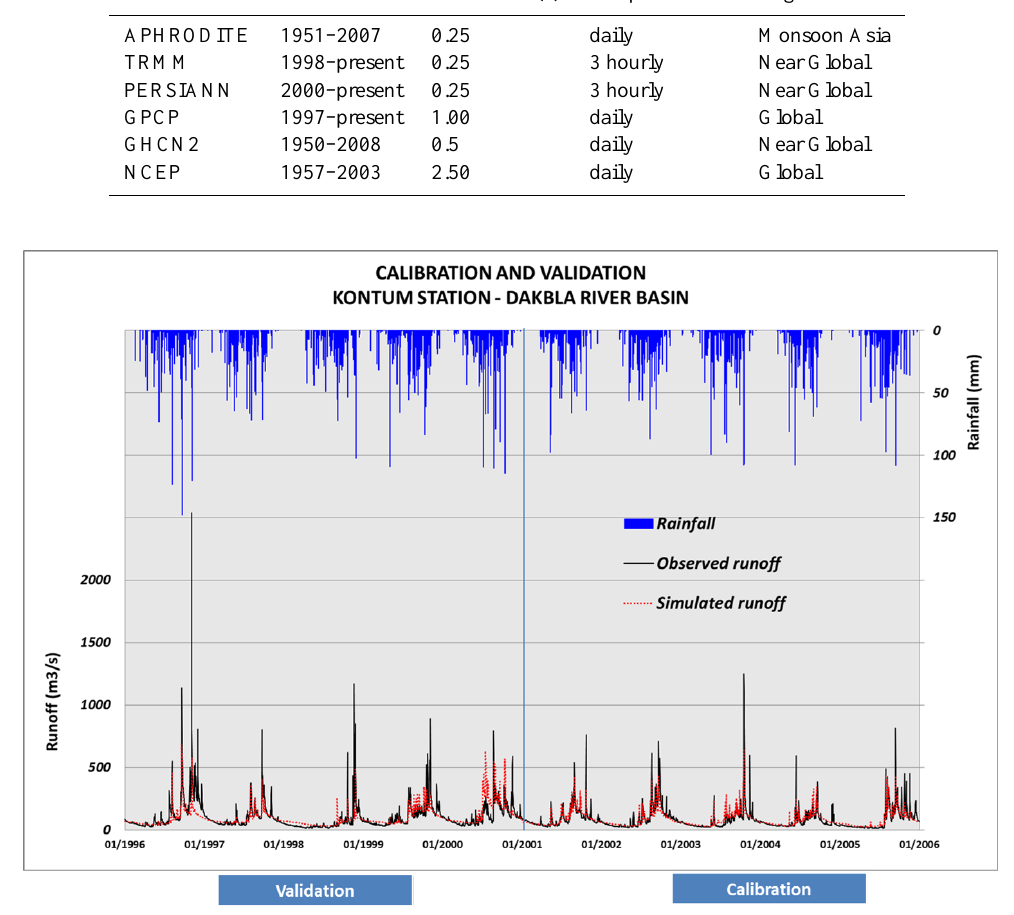
Fig. 3. Calibration and Validation using observed station rainfall for Dak Bla river basin at Kon Tum discharge gauging station